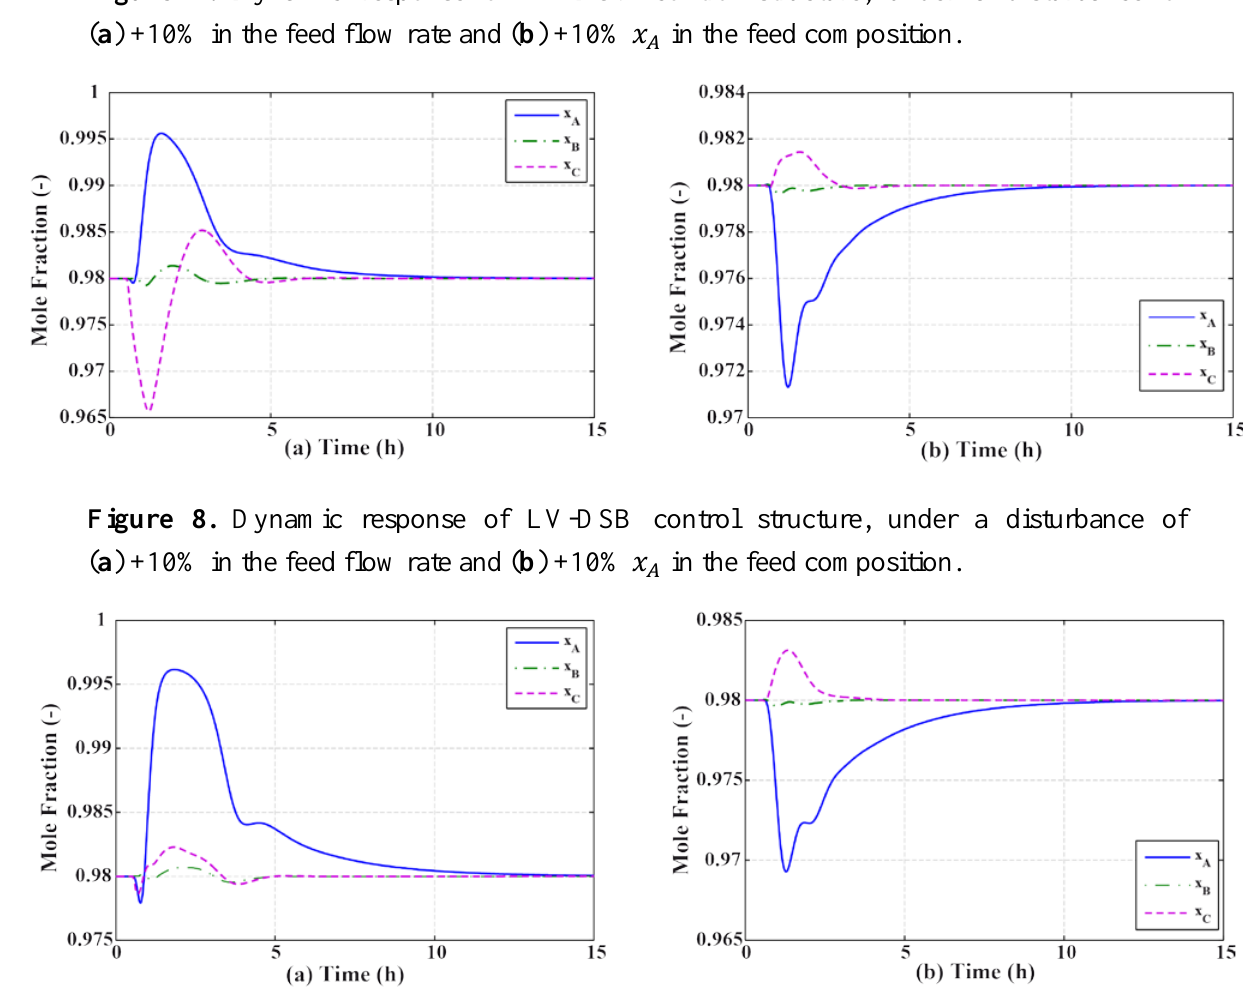
Figure 7. Dynamic response of LB-DSV control structure, under a disturbance of ( a ) +10% in the feed flow rate and ( b ) +10%